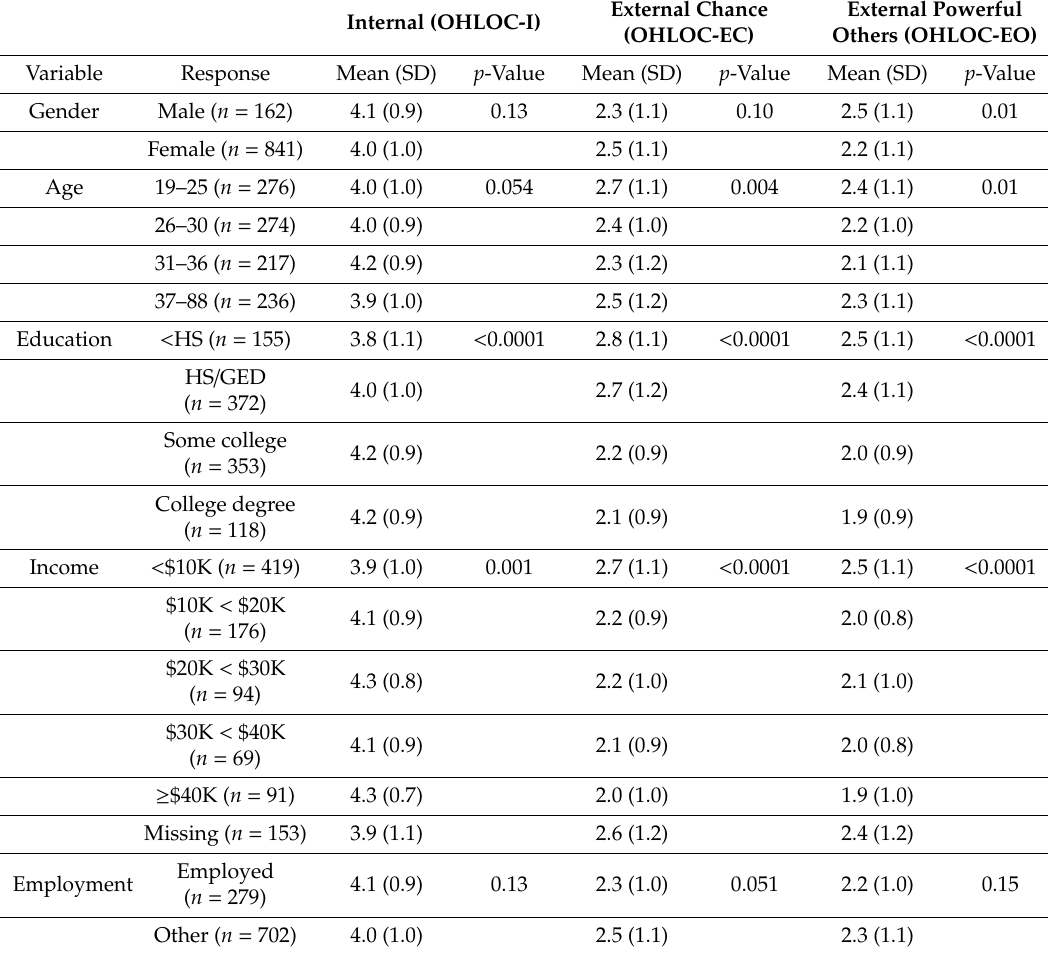
Table 3. Relationship between parent characteristics and OHLOC